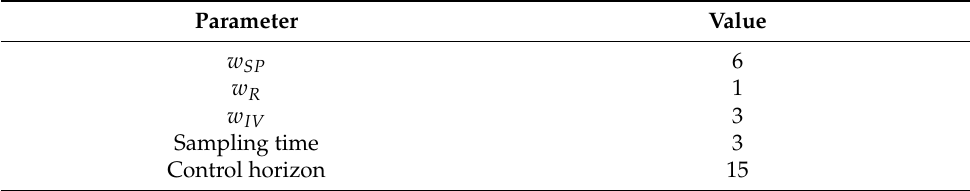
Table 1. Weights and control parameters used to obtain the FFMPC